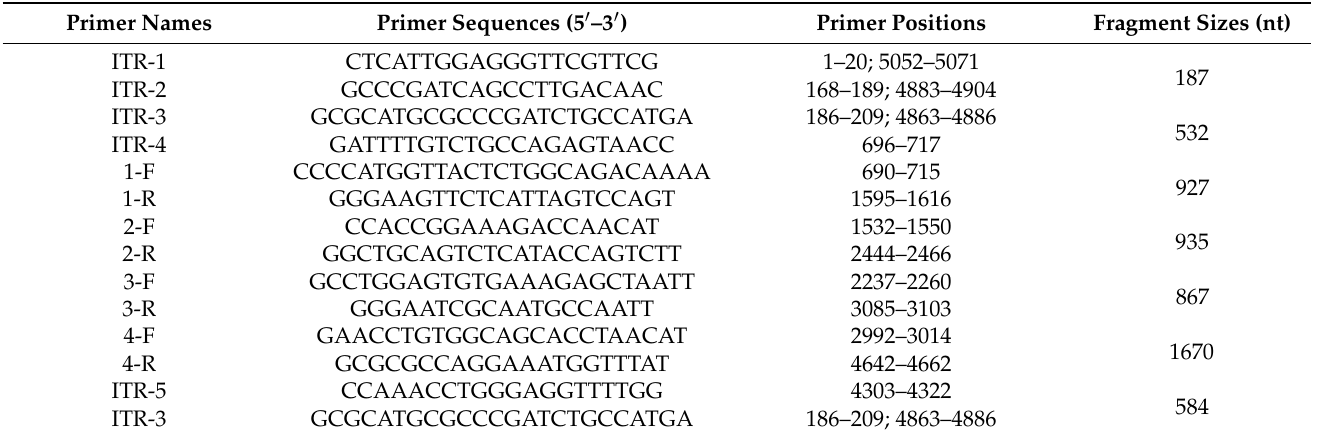
Table 2. Primer pairs designed for the amplification of complete genome of XMX